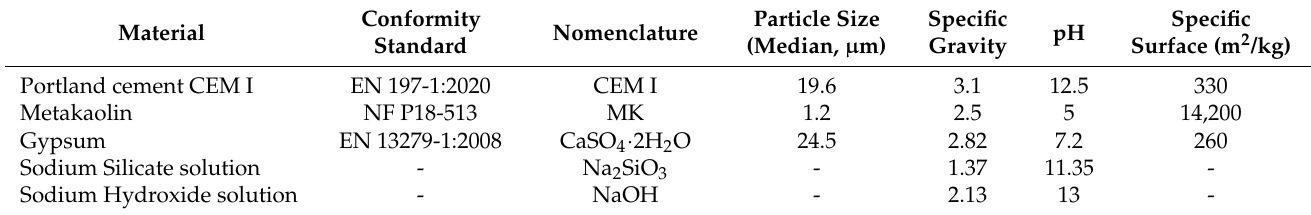
Table 2. Properties of alkaline solutions and solid used in the